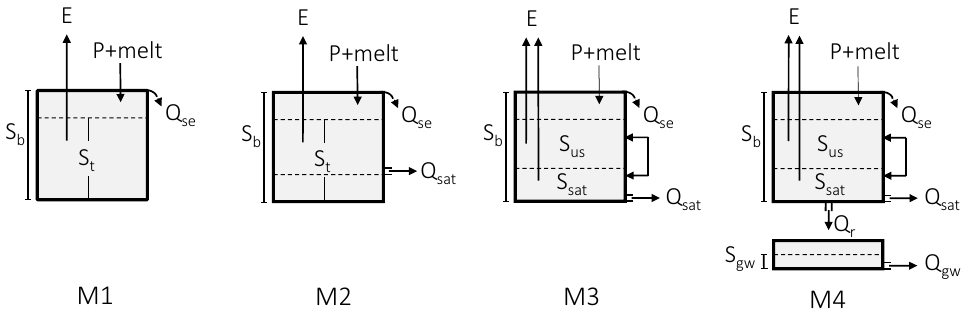
Figure 3. Sketch of the hydrological